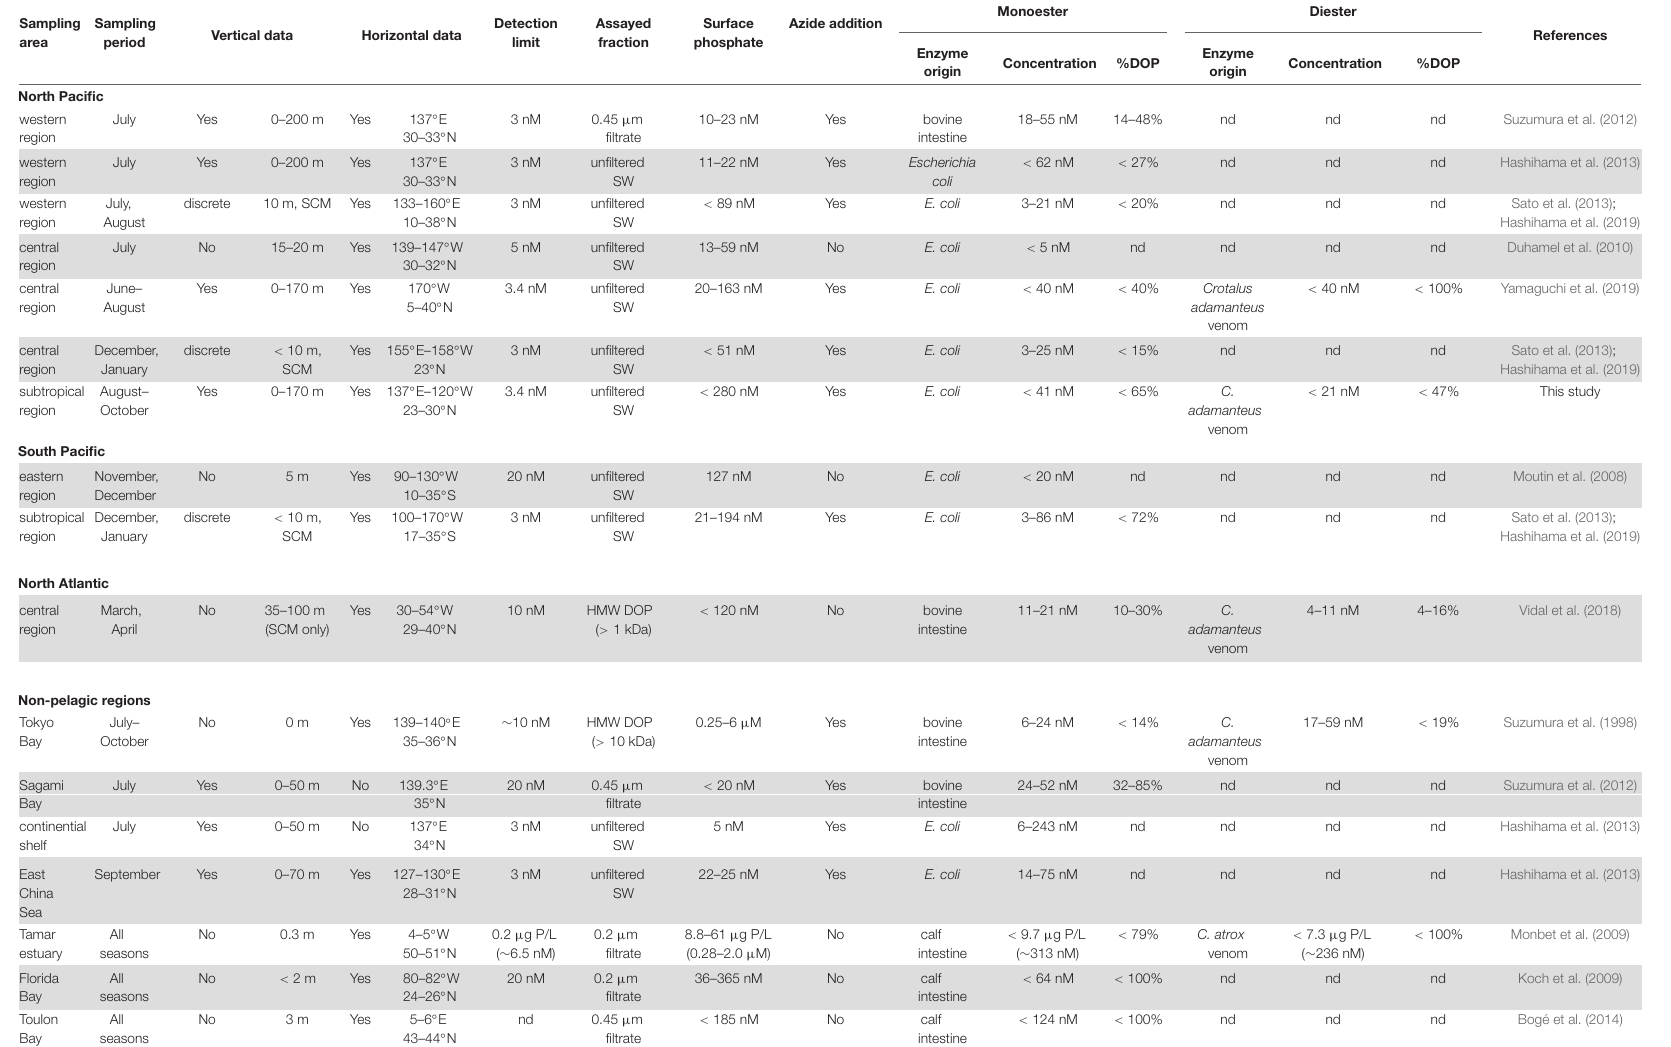
TABLE 1 | Summary data of labile phosphoric